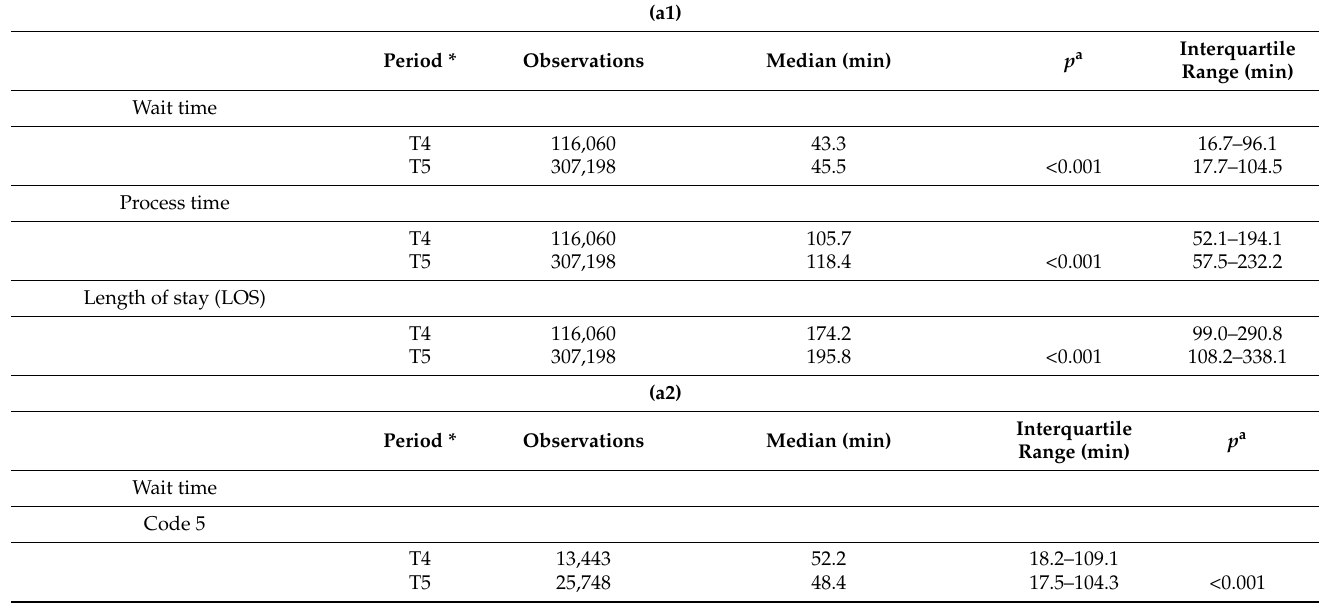
Table 2. ( a1 ) Selected time variables accounting for crowding, by period. * The 4LT period